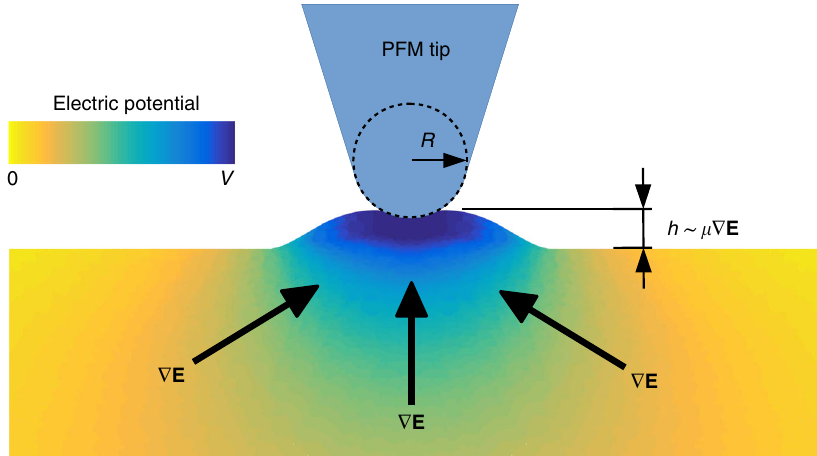
¼ h = V . However, the tip voltage induces an 33